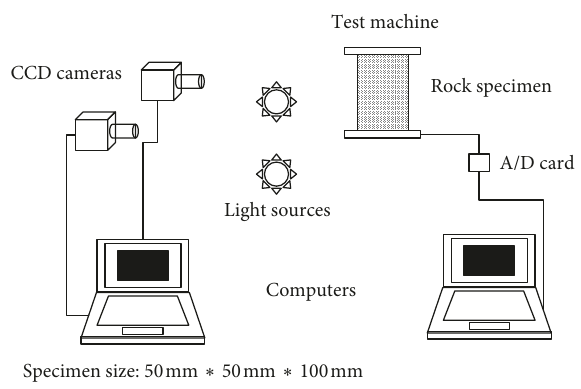
Figure 2: Schematic diagram of test